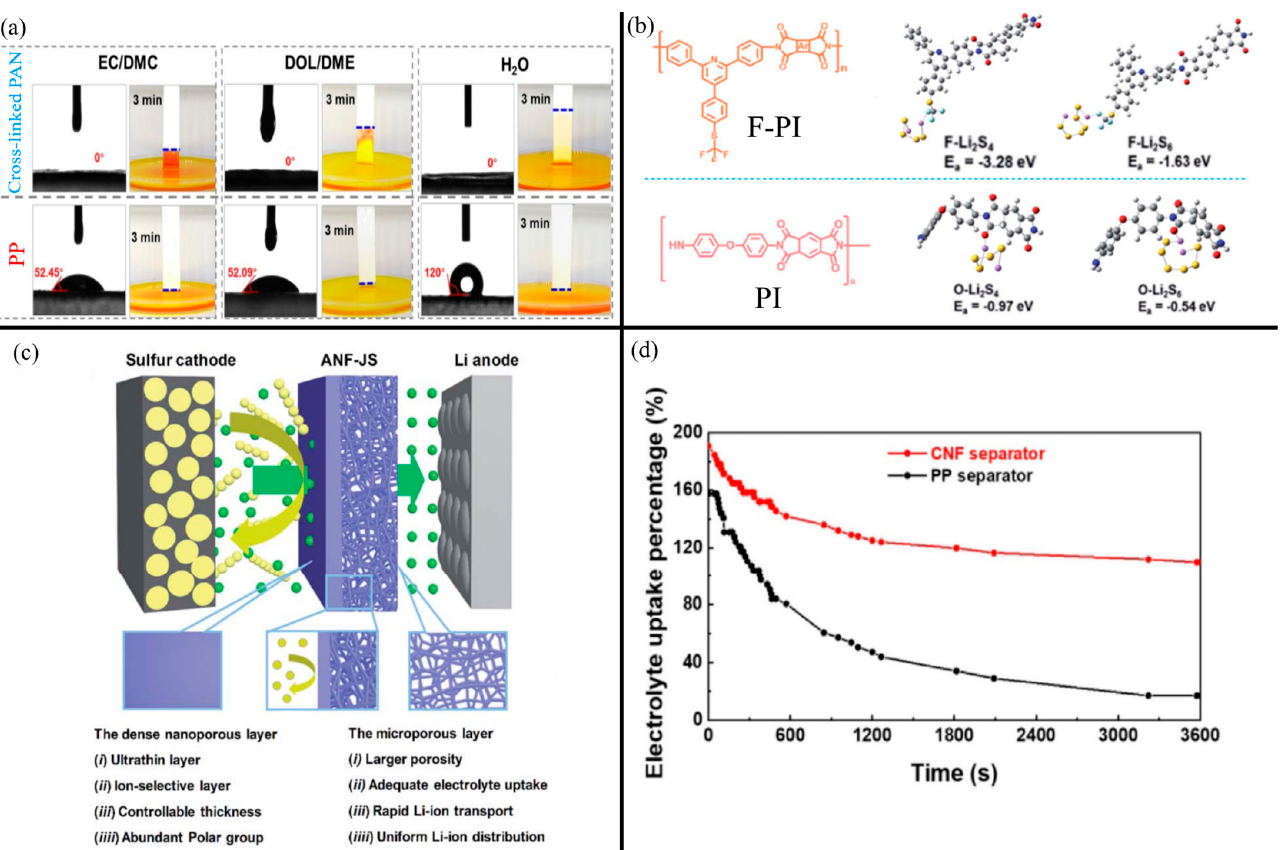
Figure 5. ( a ) Electrolyte wettability and meniscus behavior of common LSB electrolytes and water on cross-linked PAN NF separator and PP separator. Reprinted/adapted with permission from Ref. [55]. (Copyright 2021, American Chemical Society). ( b ) Chemical structures of F-PI and PI and their binding energies to Li 2 S 4 and Li 2 S 6 . Reprinted/adapted with permission from Ref. [56]. (Copyright 2020, Royal Society of Chemistry). ( c ) Schematic of a Janus-type aramid NF separator (ANF-JS), with the advantages of the dense and microporous structures listed. Reprinted/adapted with permission from Ref. [58]. (Copyright 2022, Royal Society of Chemistry). ( d ) Comparison of electrolyte uptake and storage time between a standard PP separator and CNF separator. Reprinted/adapted with permission from Ref. [59]. (Copyright 2022, Elsevier).